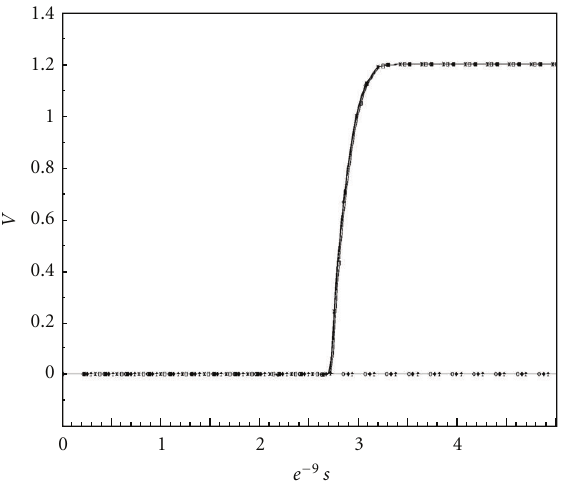
Figure 17: Outputs of Figure 8 DES submodule block implemented on a standard model